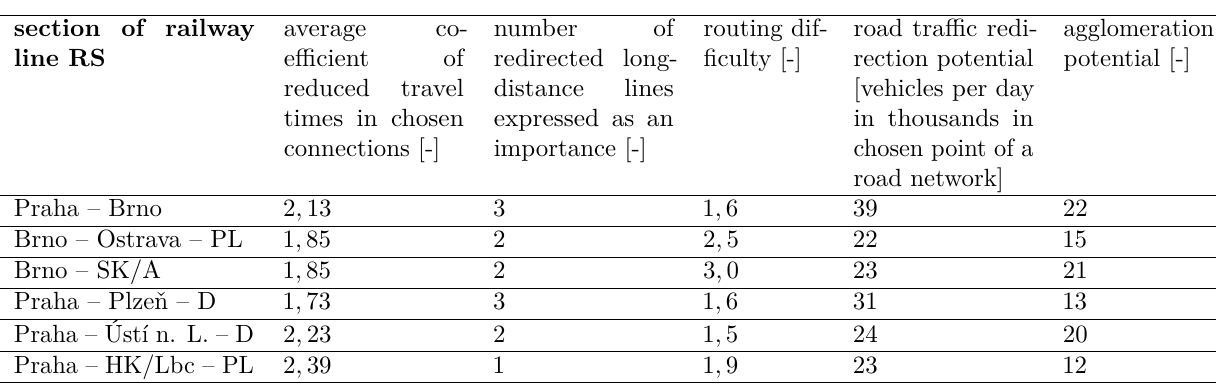
Table 1. Specific values of evaluation criteria, source: Authors.